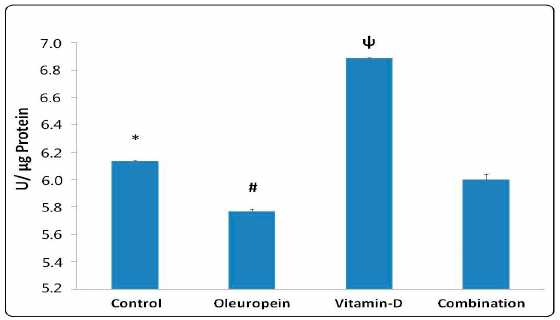
Figure 3. Superoxide dismutase analysis results. Ψ Vitamin D treatment has significantly increased SOD activity as compared to combination treatment group ( p < 0.05).